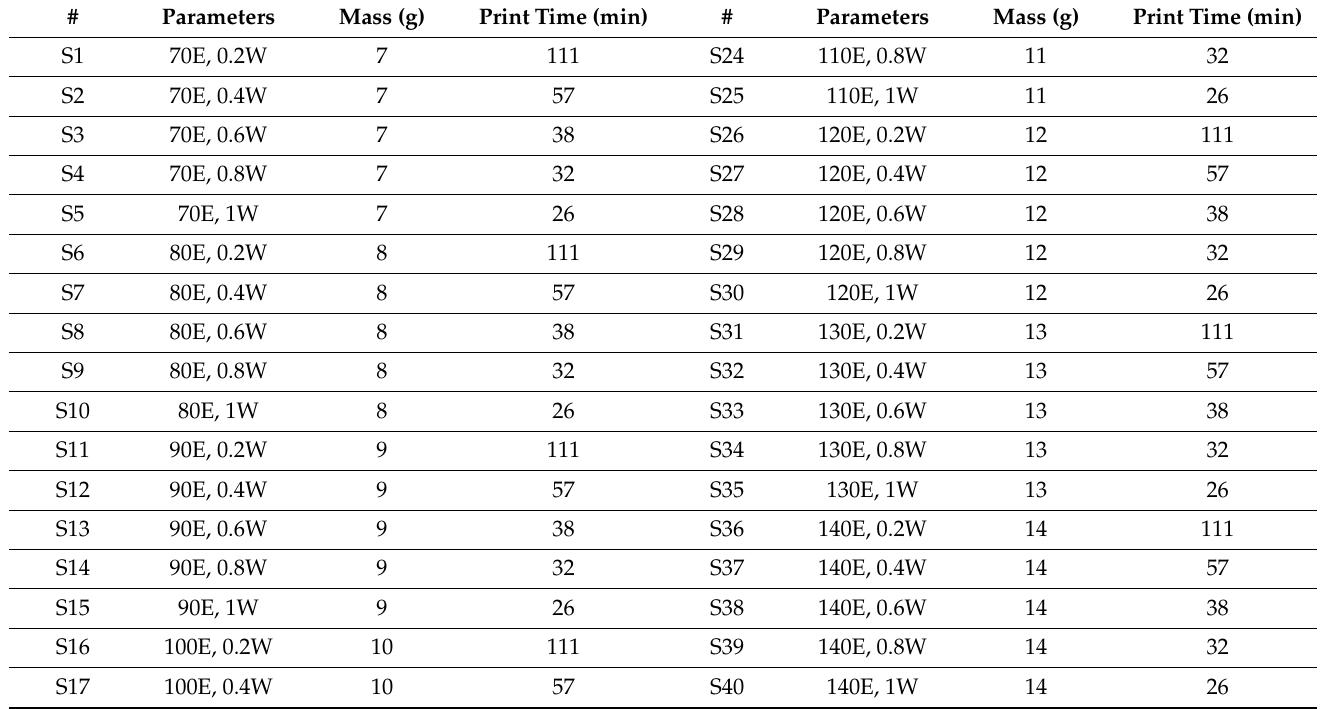
Figure 1. Printed GPLA specimens. Table 1. Combination of processing parameters (E = material extrusion rate; W = line width).